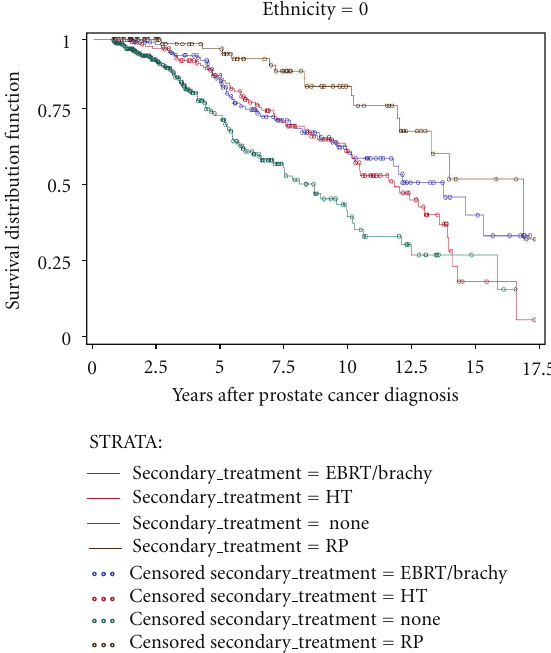
Figure 3: Kaplan Meier unadjusted estimation curve for overall survival among white men stratified by secondary treatment type among subjects with prostate cancer (CaP) followed on active surveillance (AS) for primary treatment ( n =